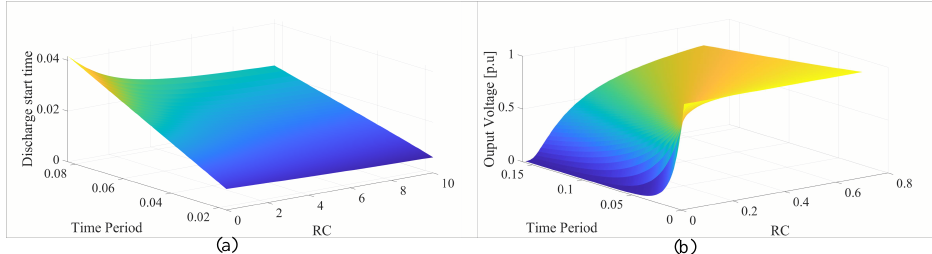
Figure 6. ( a ) Time constant vs. discharge start time; ( b ) time constant vs. output voltage.